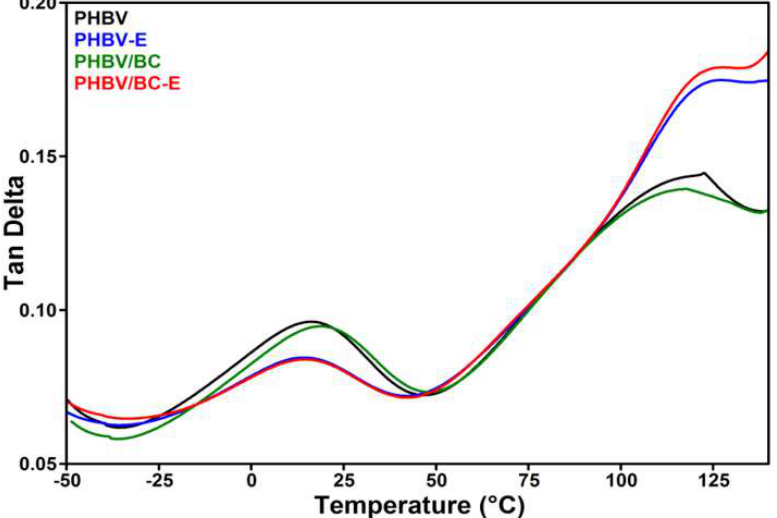
Figure 7. The variation in the mechanical damping factor (tan δ) with temperature. Table 4. DMA results: storage modulus (E (cid:48) ) values at different temperatures ( − 30 ◦ C, 30 ◦ C, 75 ◦ C, and 125 ◦ C), glass-transition temperature of PHBV (T g ), and tan δ at peak T g temperature. PHBV